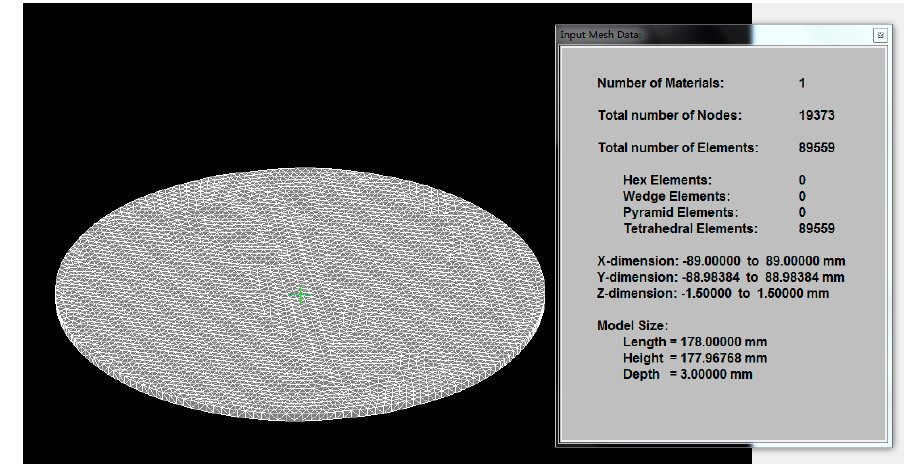
Figure 1. Simulated physical model.